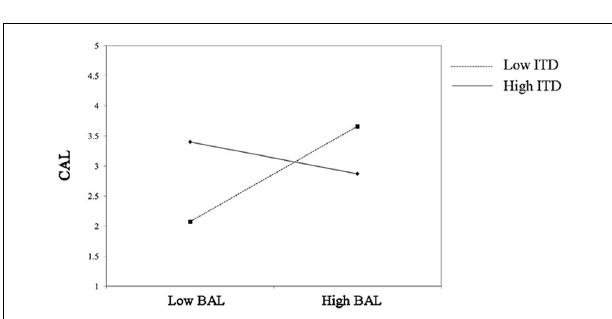
FIGURE 5 | Interaction between BAL and ITD on